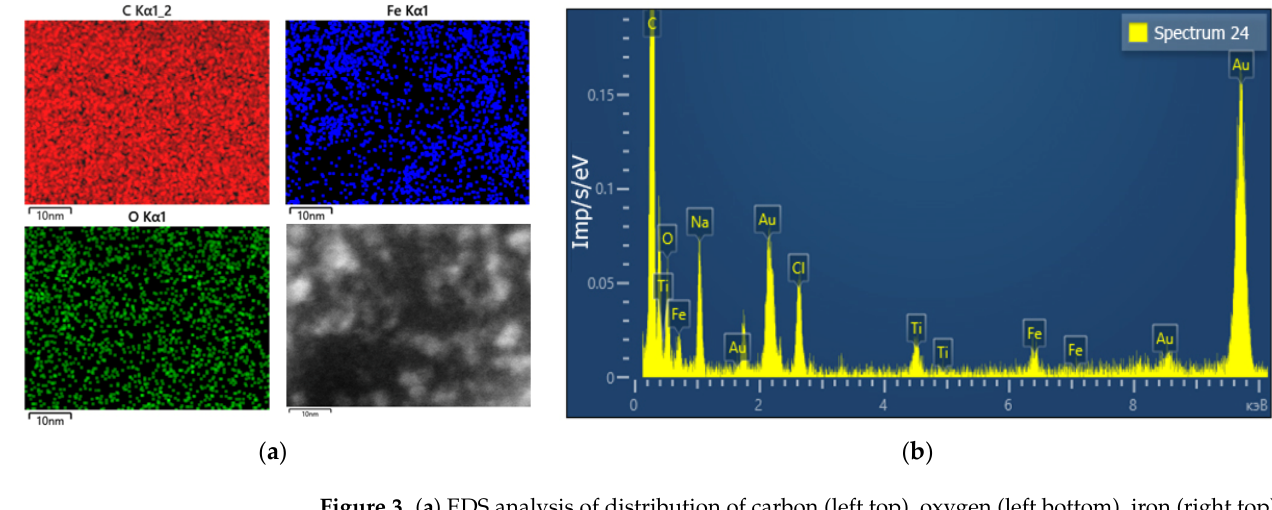
Figure 3. ( a ) EDS analysis of distribution of carbon (left top), oxygen (left bottom), iron (right top) in the sample (right bottom) TSC-IONPs (10 13 mL − 1 ) with HEWL (5 mg/mL); ( b ) energy dispersive spectroscopy results for TSC-IONPs with HEWL.